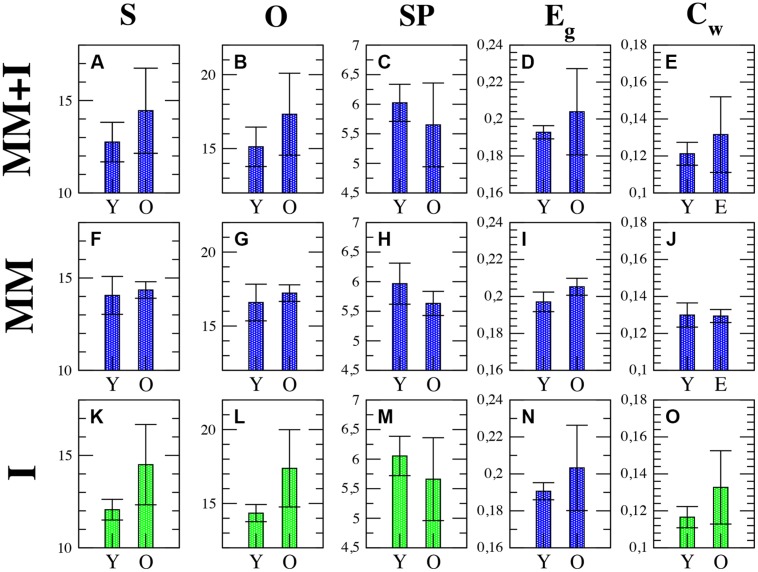
Average network parameters obtained during the whole experiment MM+I (A–E), memory maintenance MM (F–J) and interference I (K–O) windows: strength (S), outreach (O), weighted clustering coefficient (Cw), global efficiency (Eg) and average shortest path (SP). Rows refer, respectively, to MM+I, MM and I. Statistically significant parameters (p < 0.05) are highlighted in green, see Table 3 summarizing the reported p-values. Black bars represent standard error of the mean. Y = young, O = old.